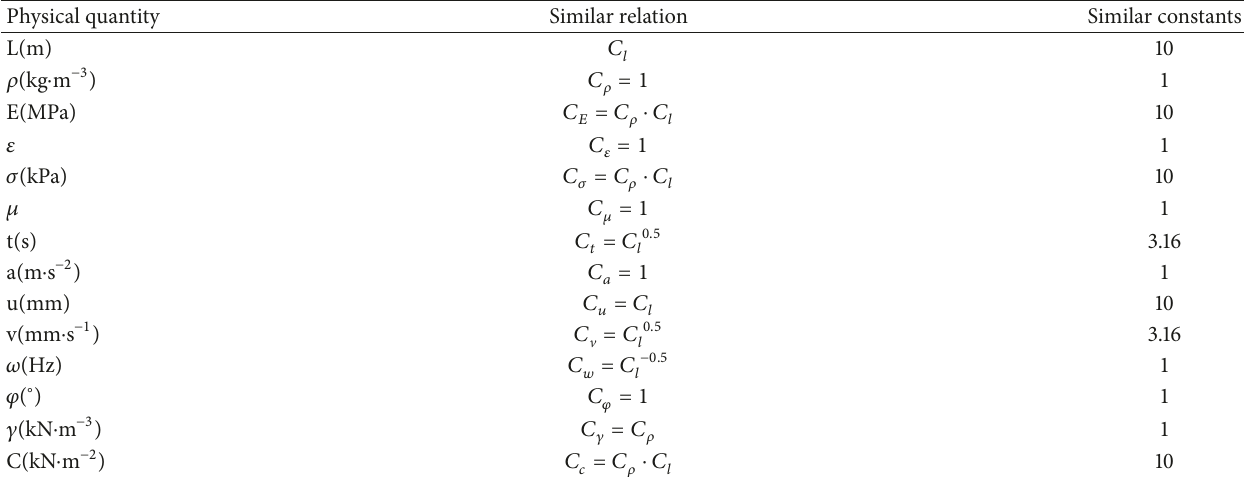
Table 1: The similar constants.